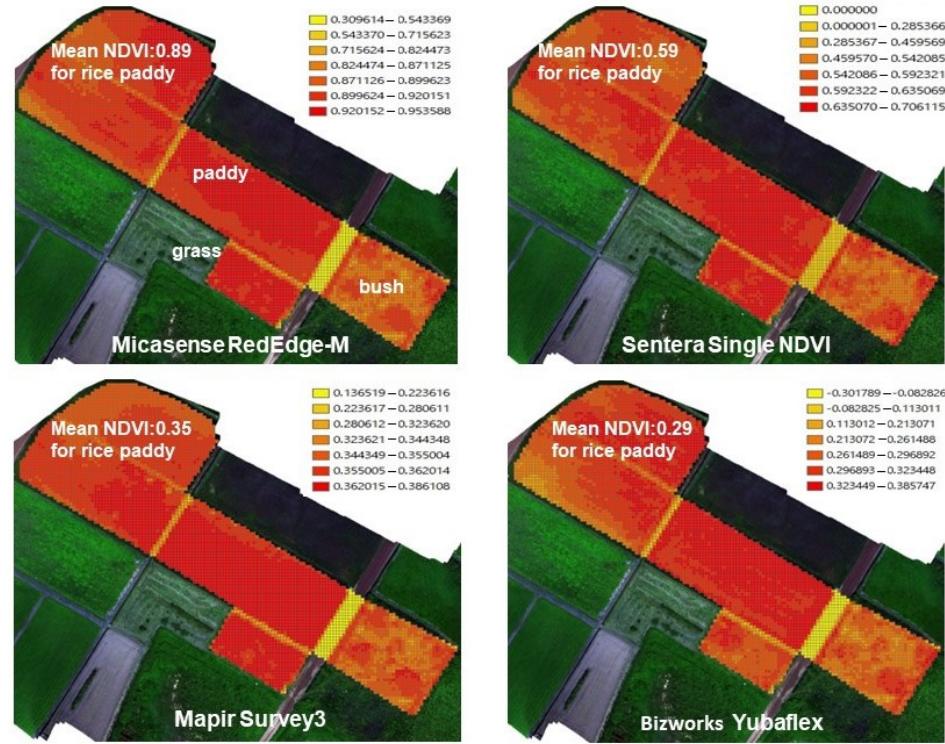
Figure 4. NDVI 1 m fishnet map by four different cameras (5th August 2020, late reproductive phase).